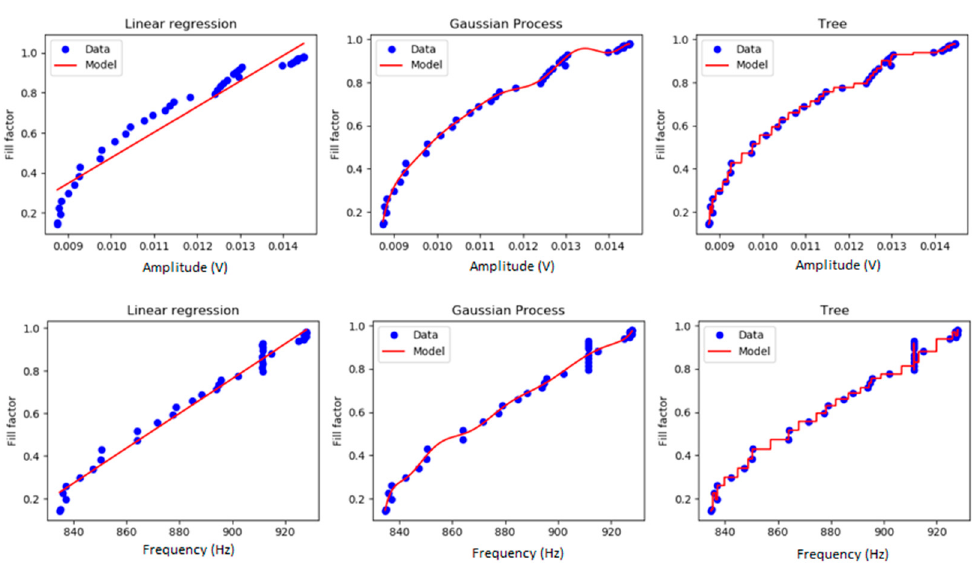
Figure 3. Linear regression, regression trees (RTs), and Gaussian processes (GPs) of the fill-factor against the amplitude (volts) and frequency (Hz) of OBT for N2A. The best results using both variables were obtained using polynomial regression with a degree of four in the polynomial regression. Using a single input variable, the best results were obtained using GPs.